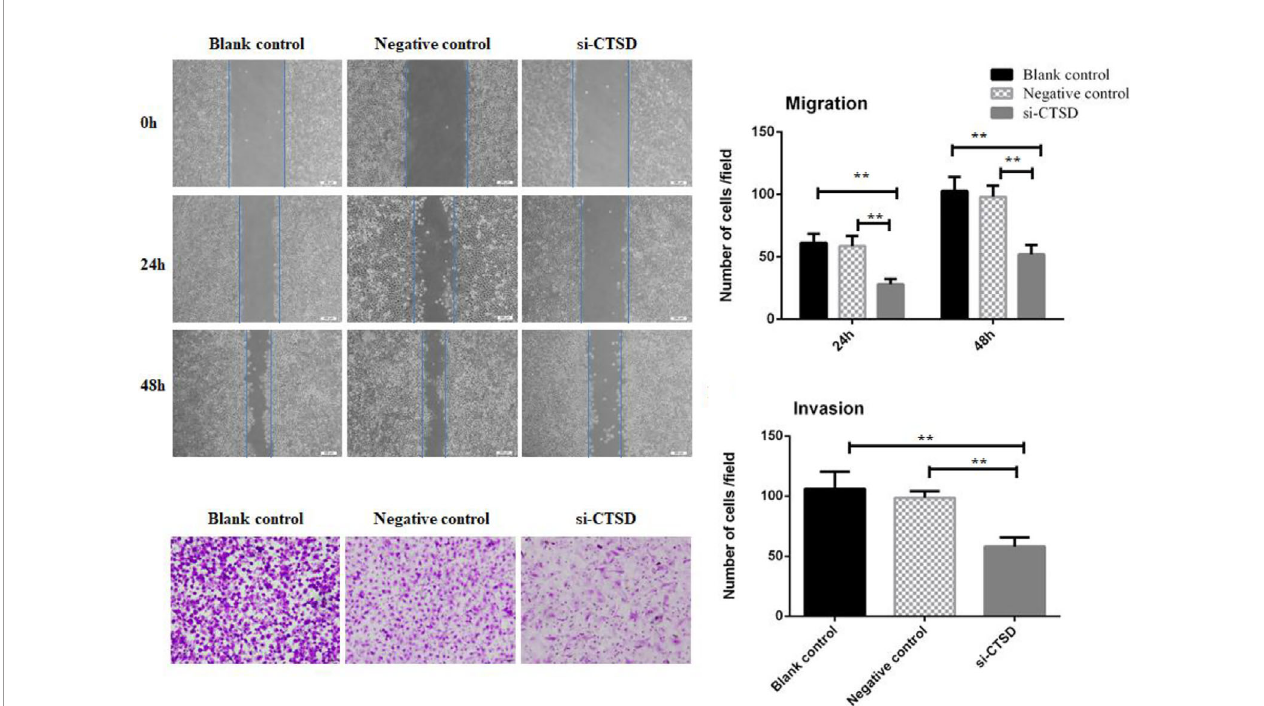
FIGURE 4 | Effect of CTSD on migration and invasion of SACC-LM cells. (A, B) Scratch wound healing assay showed that CTSD knockdown inhibited the migratory ability of SACC-LM cells, (200×). (C, D) Transwell invasion assay showed that CTSD knockdown inhibited the invasive ability of SACC-LM cells, (200×) (** p <